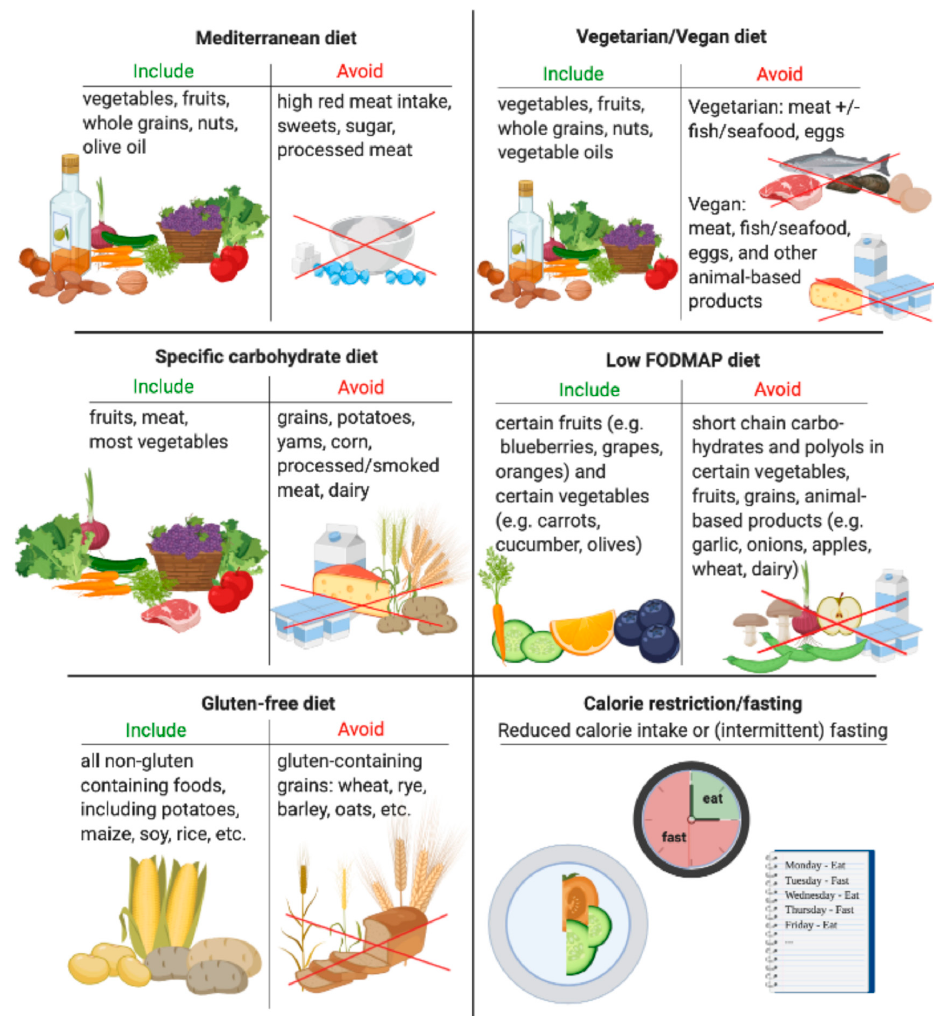
Figure 1. Components of common diets studied in irritable bowel disease